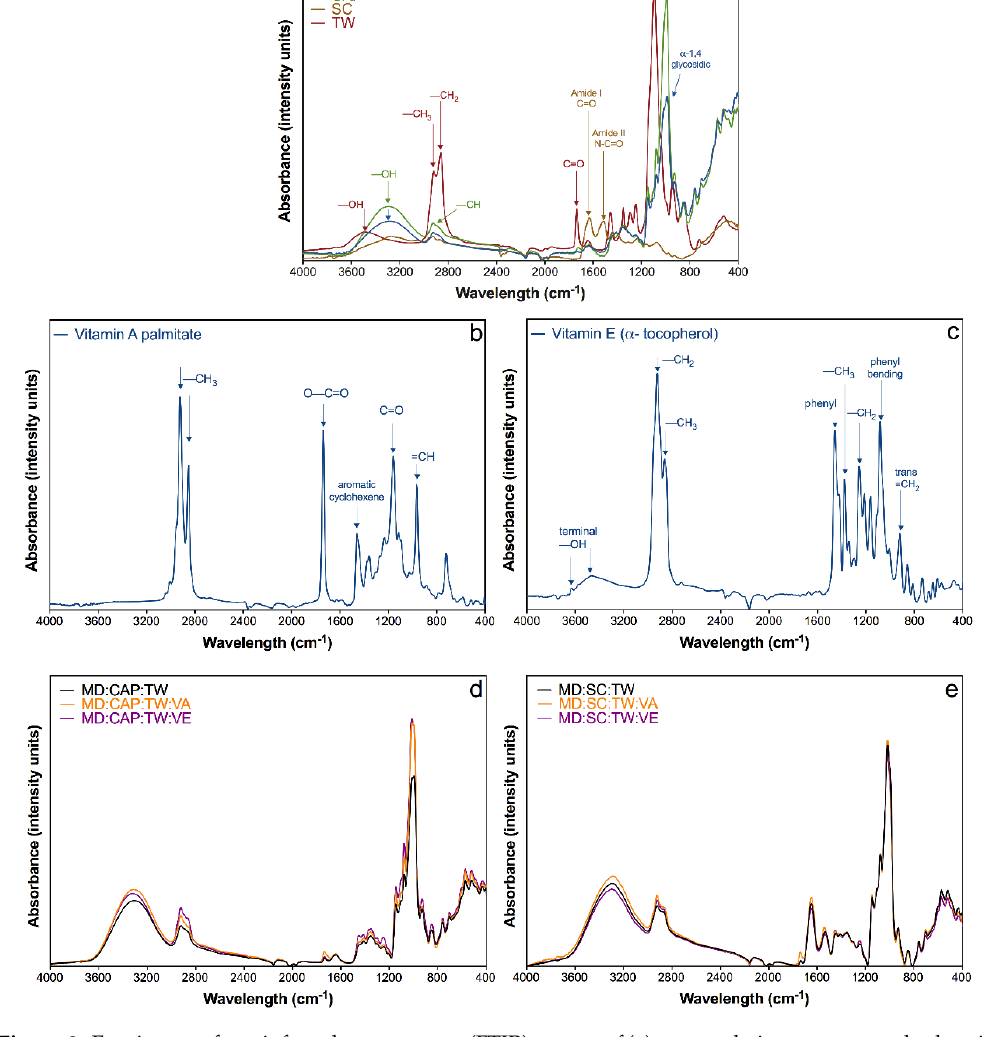
Figure 2. Fourier transform infrared spectroscopy (FTIR) spectra of ( a ) encapsulating agents— maltodextrin (MD), Capsul (CAP), sodium caseinate (SC)—and surfactant Tween 80 (TW); ( b ) Vitamin A (VA); and ( c ) Vitamin E (VE); and comparison of the vitamin encapsulation using ( d ) MD:CAP:TW and ( e ) MD:SC:TW matrices.